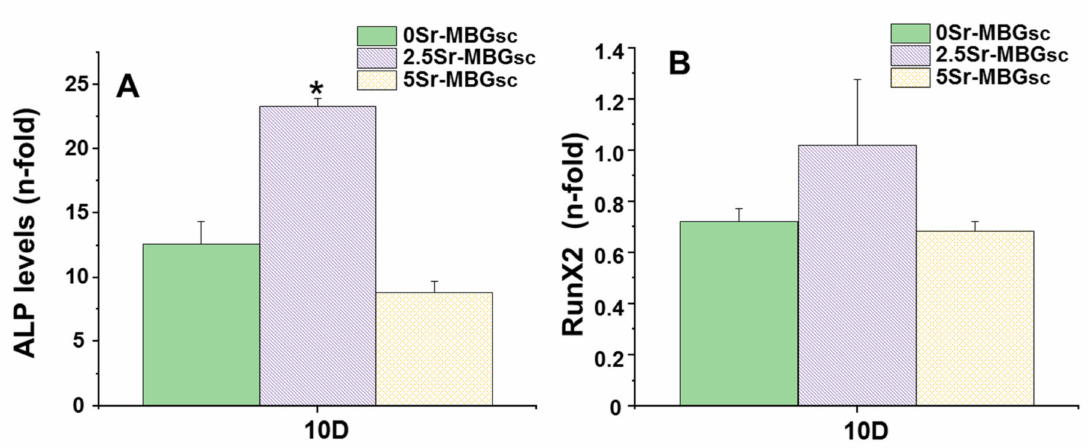
Figure 9. ( A ) ALP ( B ) RUNX2 mRNA levels in the presence of the different MBGs scaffolds at 10 d of cell culture. (*) Significant differences are shown comparing the indicated sample with the others ( p <